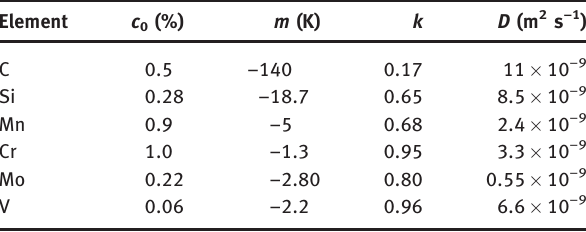
Table 1: The main parameters of the solute elements. Element